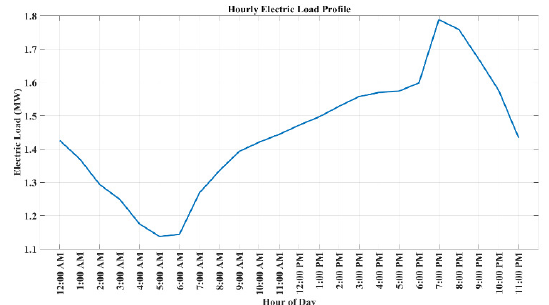
Fig. 9: Typical electrical load profile of a day